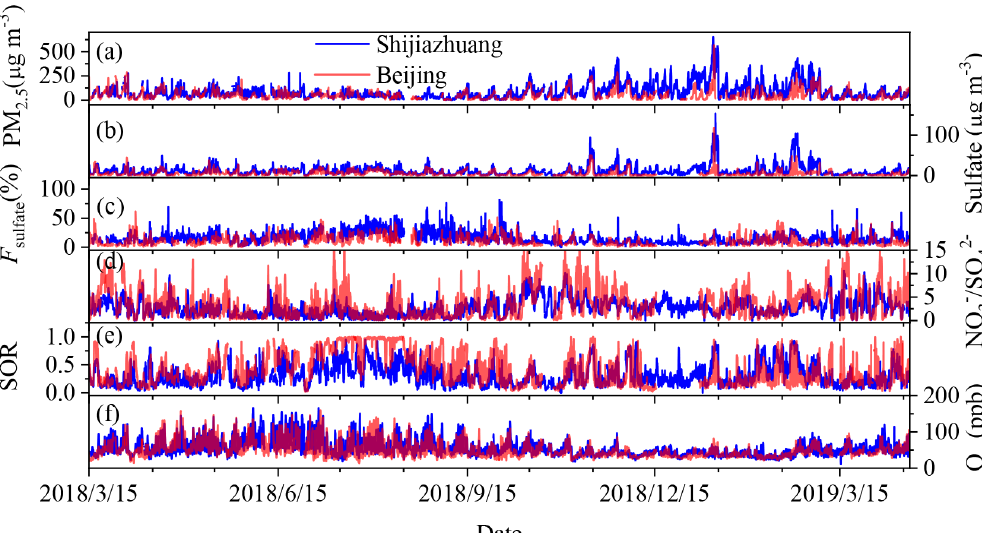
Figure 1. The hourly mean (a) mass concentration of PM 2 . 5 , (b) sulfate concentration, (c) sulfate fraction in PM 2 . 5 , (d) molar ratio of nitrate to sulfate, (e) sulfur oxidation ratio (SOR) and (e) O x ( = NO 2 + O 3 ) concentration in Shijiazhuang and Beijing from 15 March 2018 to 15 April 2019.